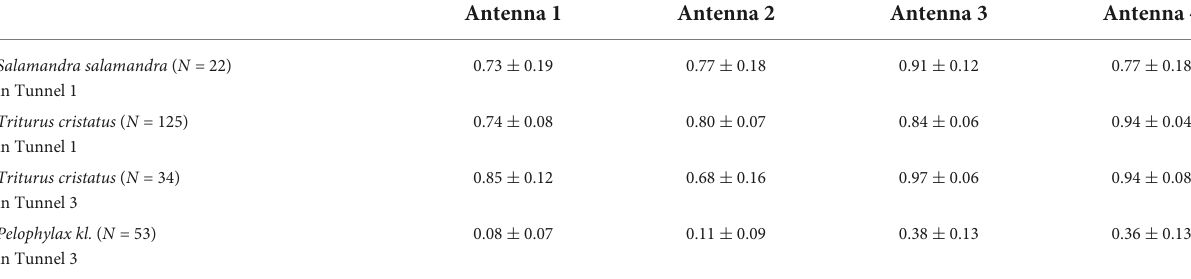
TABLE 3 Effectiveness of the antennas to detect marked individuals of the three amphibian species in Tunnel 1 (21 m in length) and Tunnel 3 (18.5 m in length).